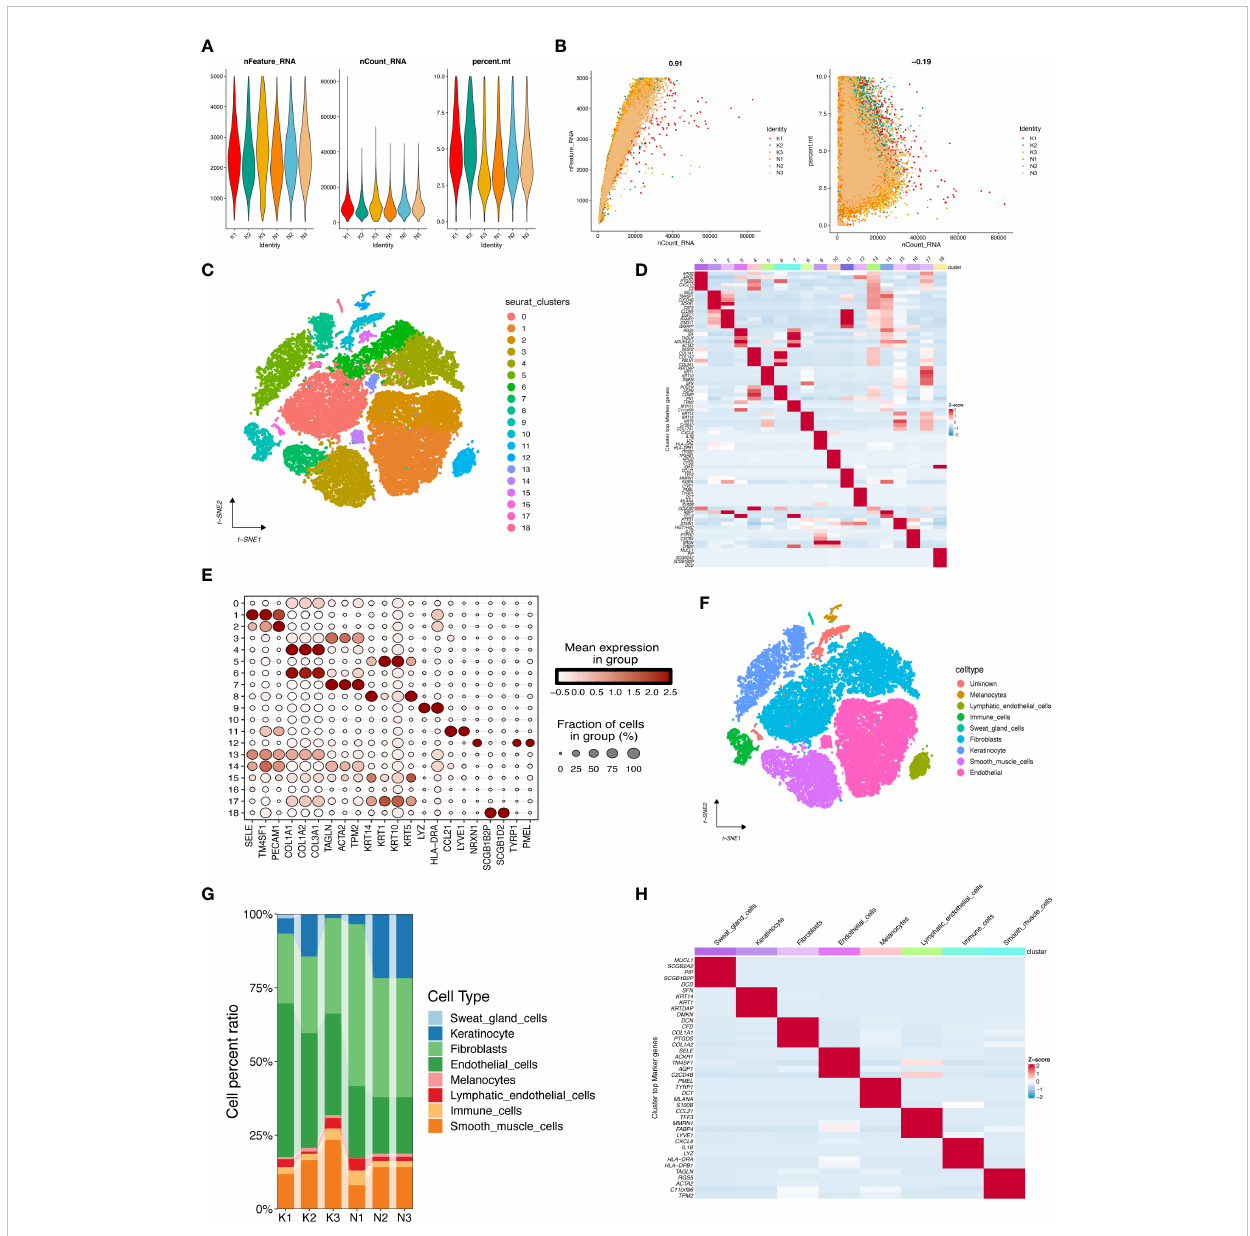
FIGURE 7 Cell populations and marker genes in keloid and normal skin. (A) After standard quality control of all cells from three keloids and three normal tissues, 43,910 cells were included in the analysis. (B) The number of genes detected was signi fi cantly correlated with the sequencing depth, with a Pearson correlation coef fi cient of 0.91; the same number of mitochondria was detected at different sequencing depths. (C) The cell clusters visualized by the dimensional reduction of t-distributed stochastic neighbor embedding (t-SNE). (D) Heatmap showing the top 5 genes per cell cluster after differential analysis to obtain marker genes. (E) Dot plot showed annotation of cell clusters by known markers. (F) tSNE plot presented cell type annotation for each cluster. (G) Proportions of distinct cell types for different samples. (H) Heatmap showed the top 5 marker genes between cell